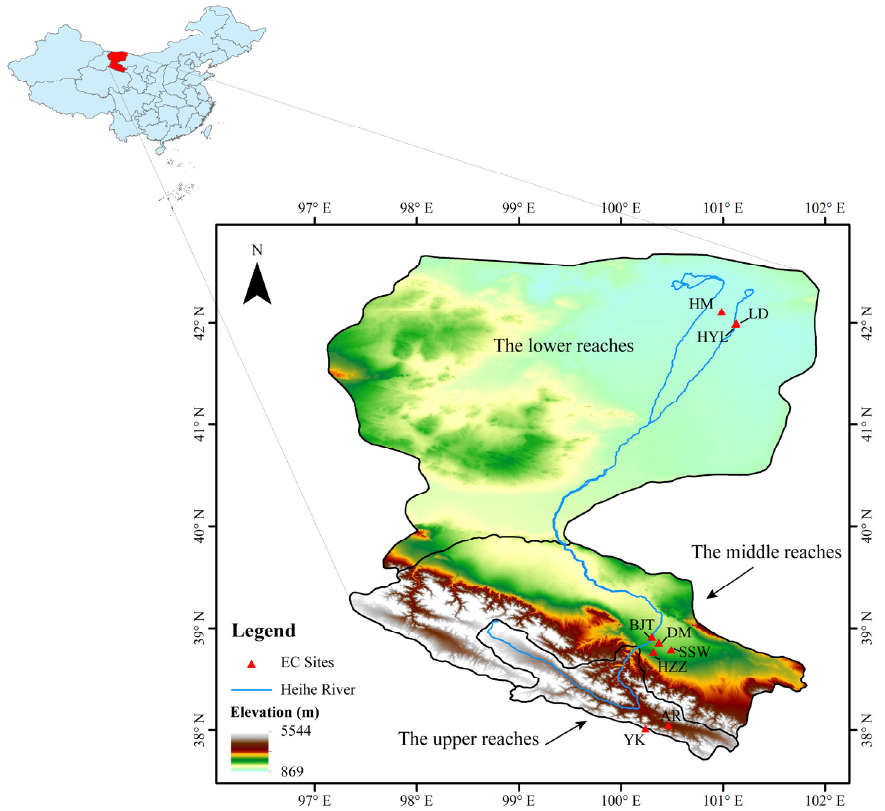
Figure 1. Location of the flux tower sites and topography of the Heihe River Basin.